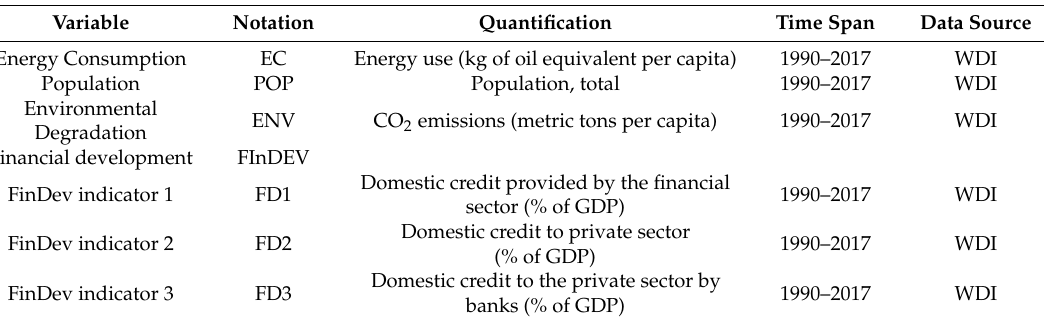
Table 2. Variable